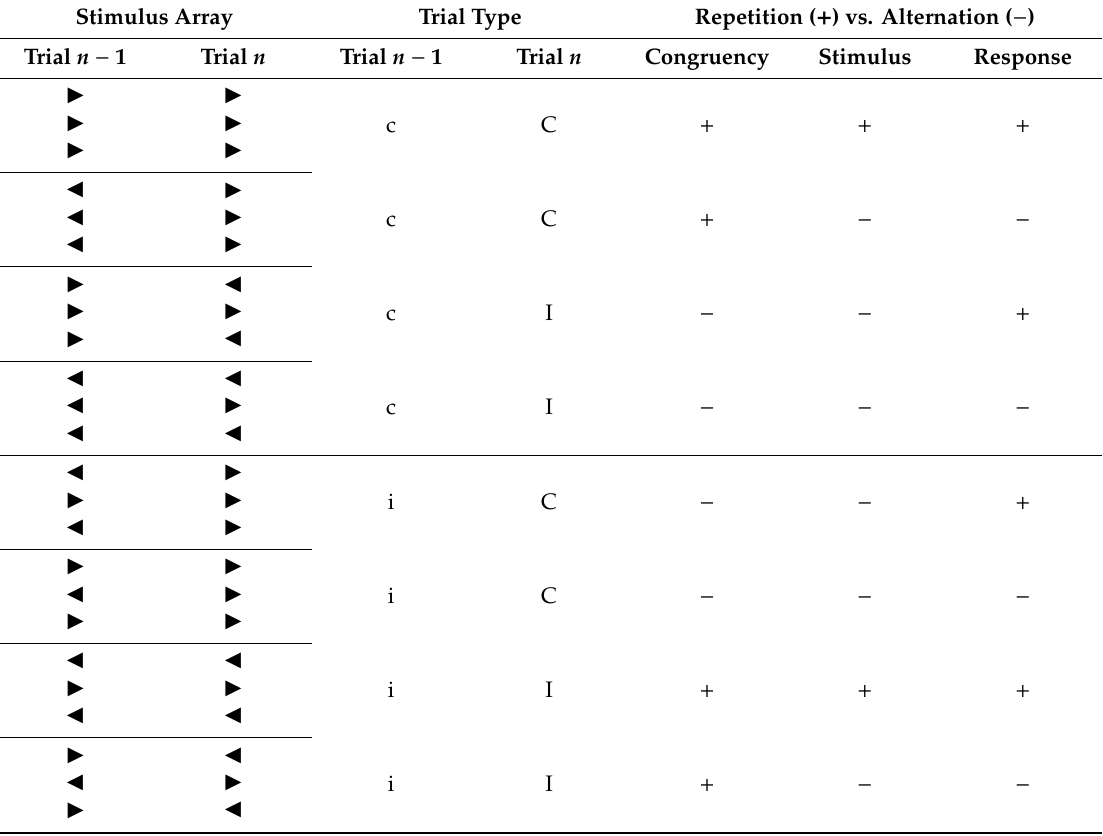
Table 2. Possible trial sequences.